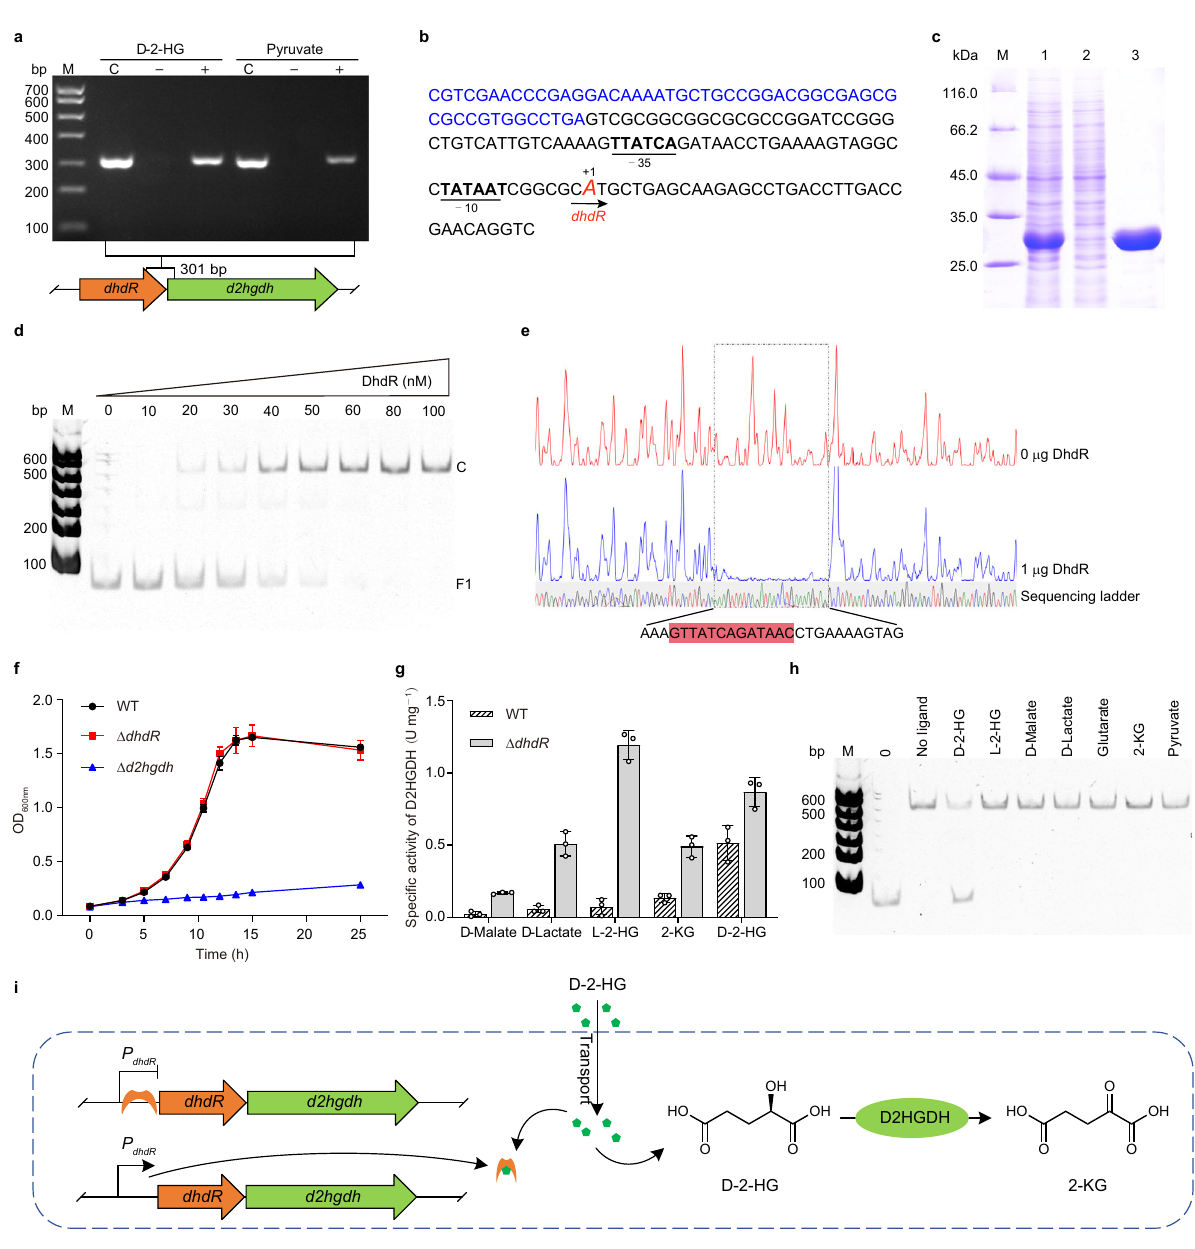
Fig. 2 DhdR negatively regulates the catabolism of D -2-HG. a Identi fi cation of the cotranscription of dhdR and d2hgdh in the presence of D -2-HG or pyruvate by RT-PCR. Lanes C, genomic DNA as template; lanes + , cDNA as template; lanes − , RNA as template; lane M, DNA ladder marker. The amplicon locations are indicated in panel a . b Map of the intergenic region upstream of dhdR - d2hgdh operon. Transcriptional start site (TSS) is shown in enlarged red letter and marked by + 1. The putative − 35 and − 10 regions are shown in bold and underlined. The translational start codon of dhdR is shown in italics. c SDS-PAGE analysis of puri fi ed DhdR. Lane M, molecular weight markers; lane 1, crude extract of E. coli BL21(DE3) harboring pETDuet- dhdR ; lane 2, the unbound protein of the HisTrap HP column; lane 3, puri fi ed DhdR using a HisTrap column. d EMSAs with the 81-bp fragment (F1) upstream of dhdR (10 nM) and puri fi ed DhdR (0, 10, 20, 30, 40, 50, 60, 80, and 100 nM). C, complex of DhdR-F1. e DNase I footprinting analysis of DhdR binding to the dhdR promoter region. Sequences of DhdR protected region are shown at the bottom and the palindrome sequences are indicated with a red box. f Growth of A. denitri fi cans NBRC 15125 and its derivatives cultured in minimal medium containing 3 g L − 1 D -2-HG. Data shown are mean ± s.d. ( n = 3 independent experiments). g Activity of D2HGDH in A. denitri fi cans NBRC 15125 and A. denitri fi cans NBRC 15125 ( Δ dhdR ) cultured in minimal medium with different compounds as the sole carbon source. Data shown are mean ± s.d. ( n = 3 independent experiments). h D -2-HG prevents DhdR binding to F1. The leftmost lane without DhdR (0) shows the migration of free DNA. Lane M, DNA ladder marker. C, complex of DhdR-F1. i Proposed model for the regulation of D -2- HG catabolism by DhdR in A. denitri fi cans NBRC 15125. DhdR represses the expression of dhdR-d2hgdh genes. D -2-HG is the effector of DhdR and prevents DhdR binding to the dhdR promoter region. Source data are provided as a Source Data fi